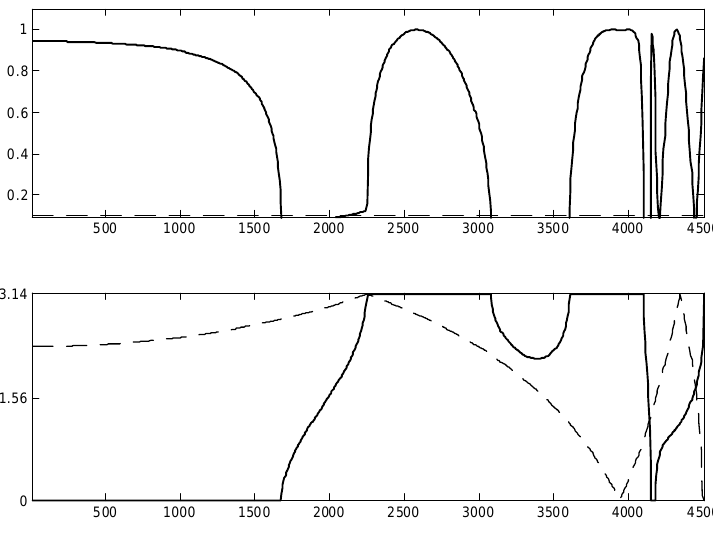
Fig. 16. Propagation characteristics of a periodic tapered shell type